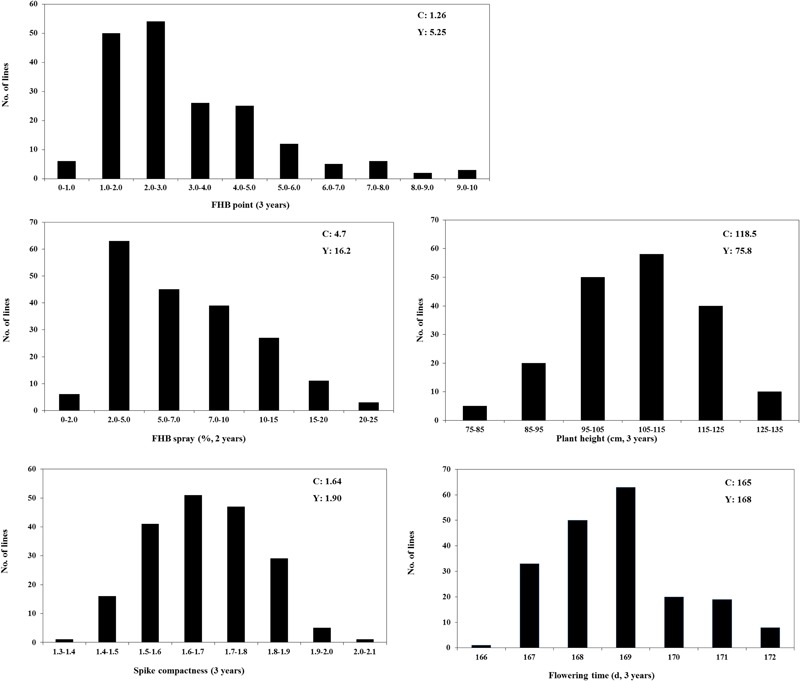
Frequency distributions for FHB, Plant height, Spike compactness, and Days to Flowering in the C615/Yangmai 13 RIL population based on the mean data across environments. C: C615, Y: Yangmai 13.